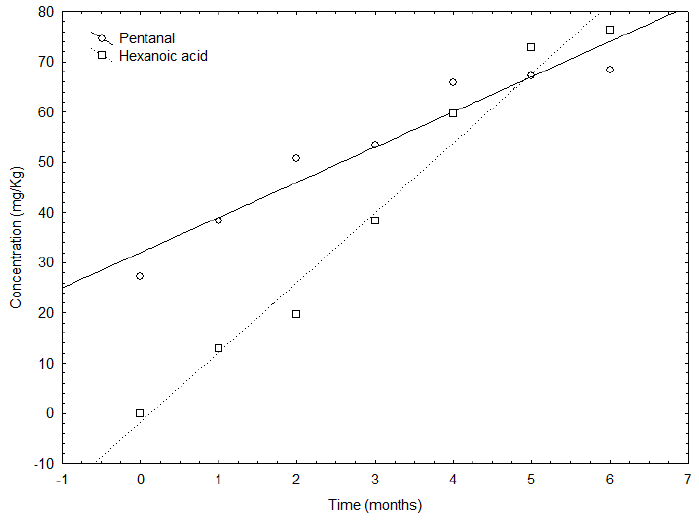
Figure 1. Evolution of pentanal and hexanoic acid concentration (mg/Kg) during the storage in VOO samples.